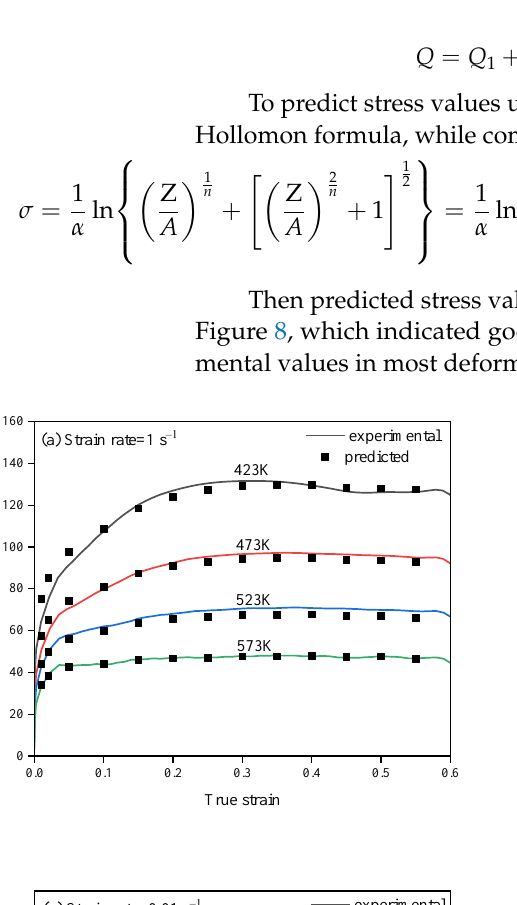
experimental predicted(c) Strain rate=0.01 s –1